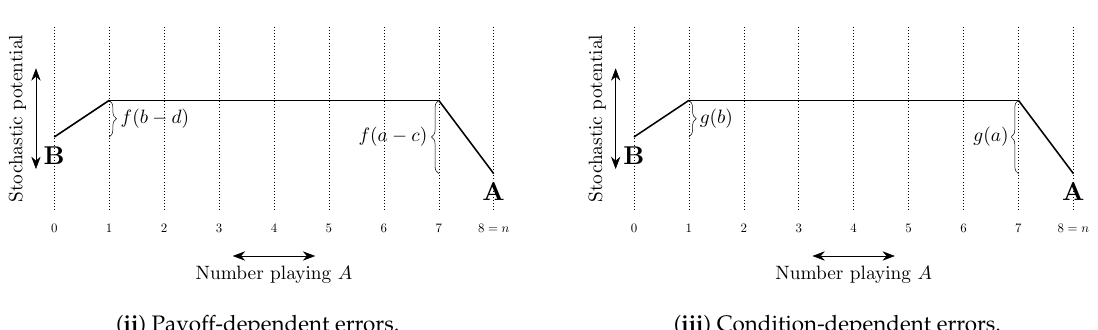
Figure 11. Stochastic potential under perturbed best response for coordination games under infrequent rematching. The game in Figure 10 is played by a population of size n = 8. As rematching is infrequent, any updating individual chooses the same action as his current partner, so a path escaping the basin of attraction of any convention only requires a single error. In Panel ( i ), as all errors have equal steepness, this results in both conventions being stochastically stable. In Panel ( ii ), payoff losses b d and a c are compared, resulting in the risk dominant convention being stochastically stable. − − In Panel ( iii ), current conventional payoffs b and a are compared, resulting in the payoff dominant convention being stochastically